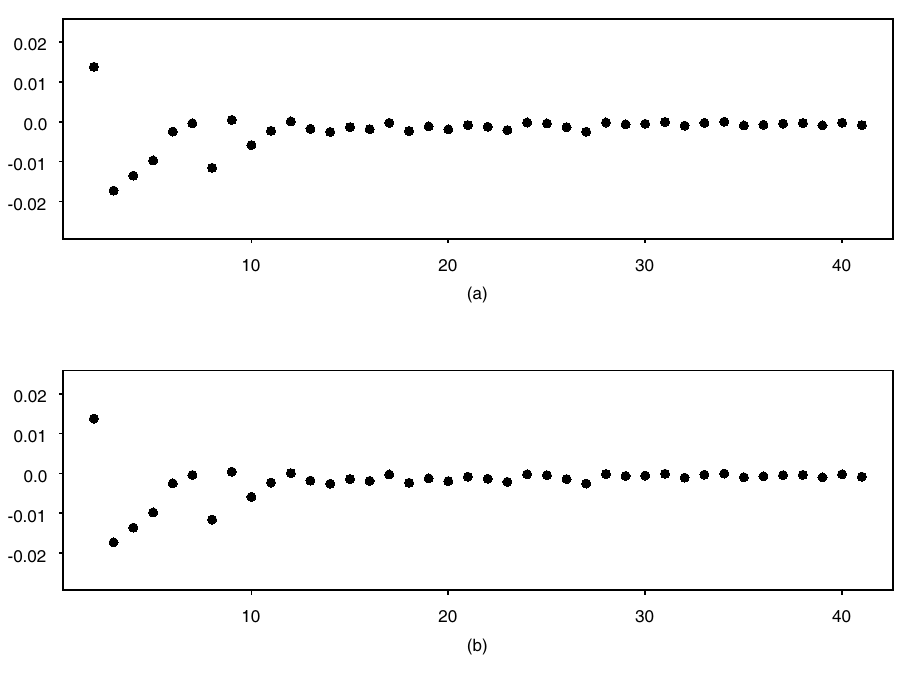
Figure 2 – Difference between the sample ratio of means (x) g and its basic linear approximation given by (4) (panel (a)), and difference between (x) g and its higher-order sample linear approxima- tion given by (5) (panel (b)), for 40 different sample sizes n (horizontal axes) ranging from 2 n (cid:32) to 41 n